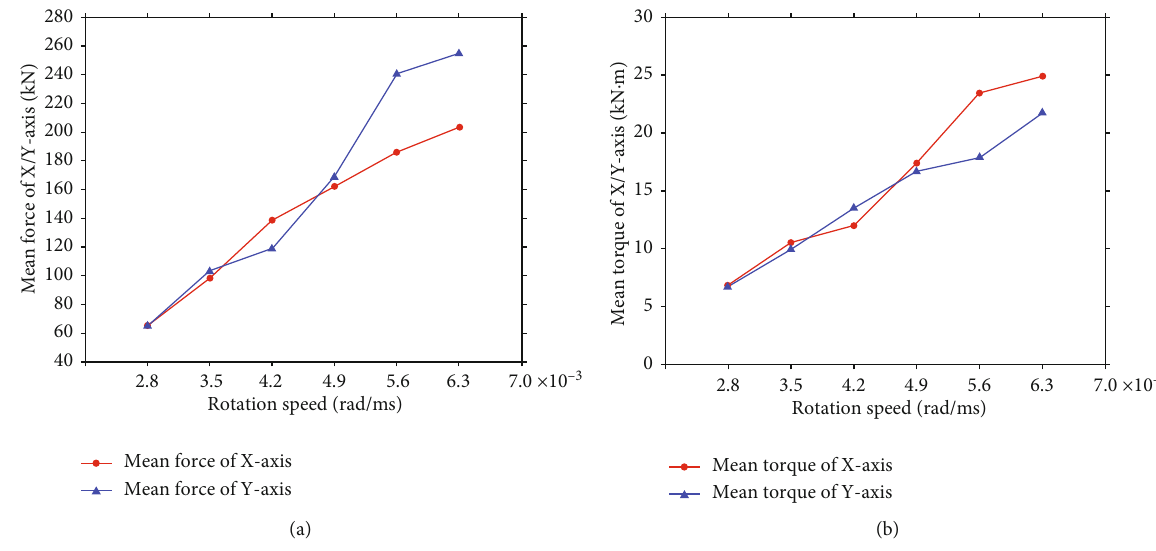
Figure 9: The impact of rotation speeds on mean force and torque on the PDC teeth of bionic blade. (a) Mean force. (b) Mean